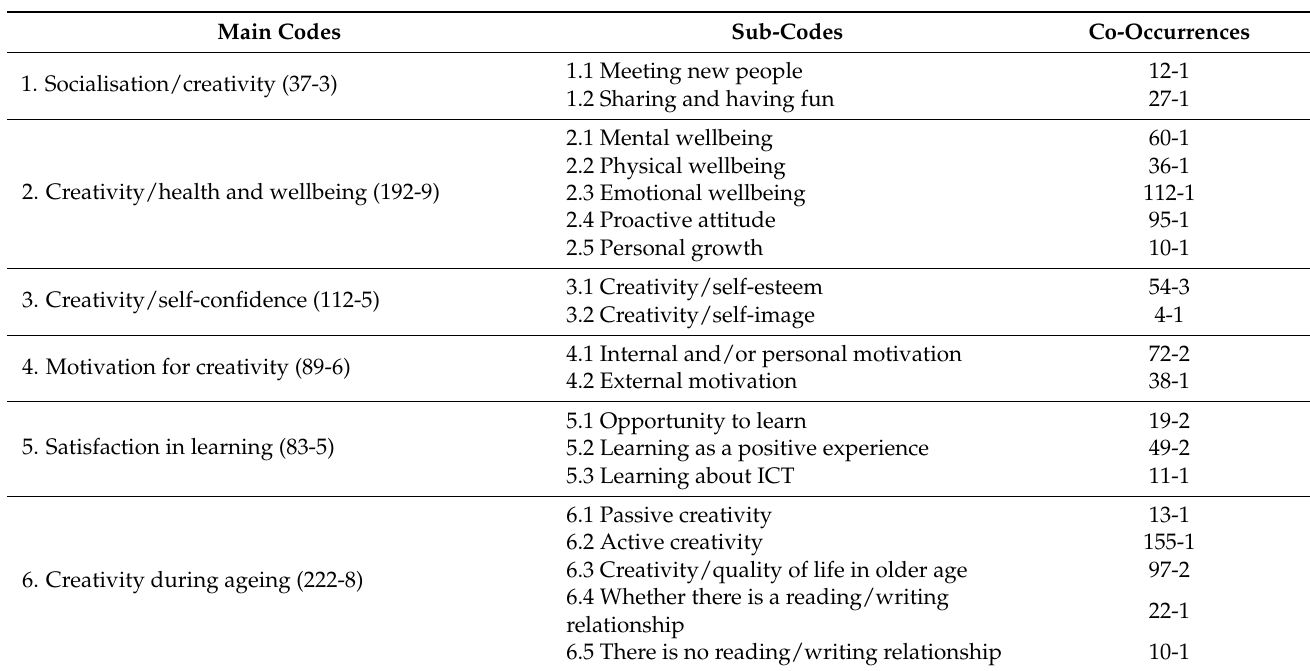
Table 1. Codification of